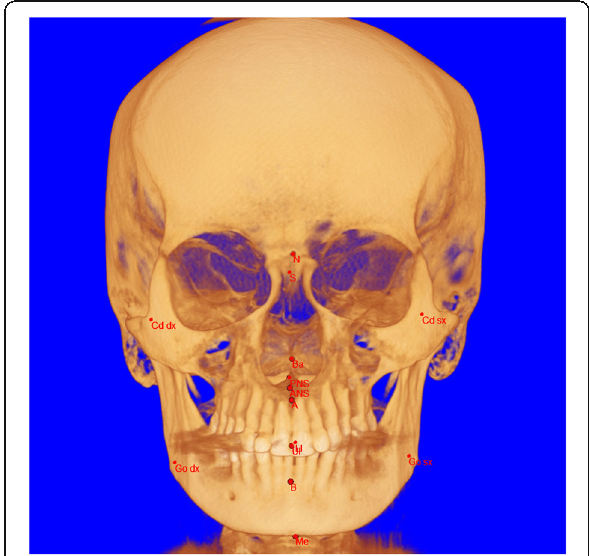
Fig. 1 Cephalometric landmarks used in the present study. A total of 10 midsagittal and 8 bilateral landmarks were included in the cephalometric analysis: A = point A (most concave point of anterior maxilla); B = point B (most concave point of mandibular symphysis); ANS = anterior nasal spine; PNS = posterior nasal spine; Go = gonion; Ba = basion; S = sella; N = nasion; Cd = condylion; Go = gonion; LI = lower incisor; Me = menton; UI = upper incisor; Li = lower incisor; L/R =